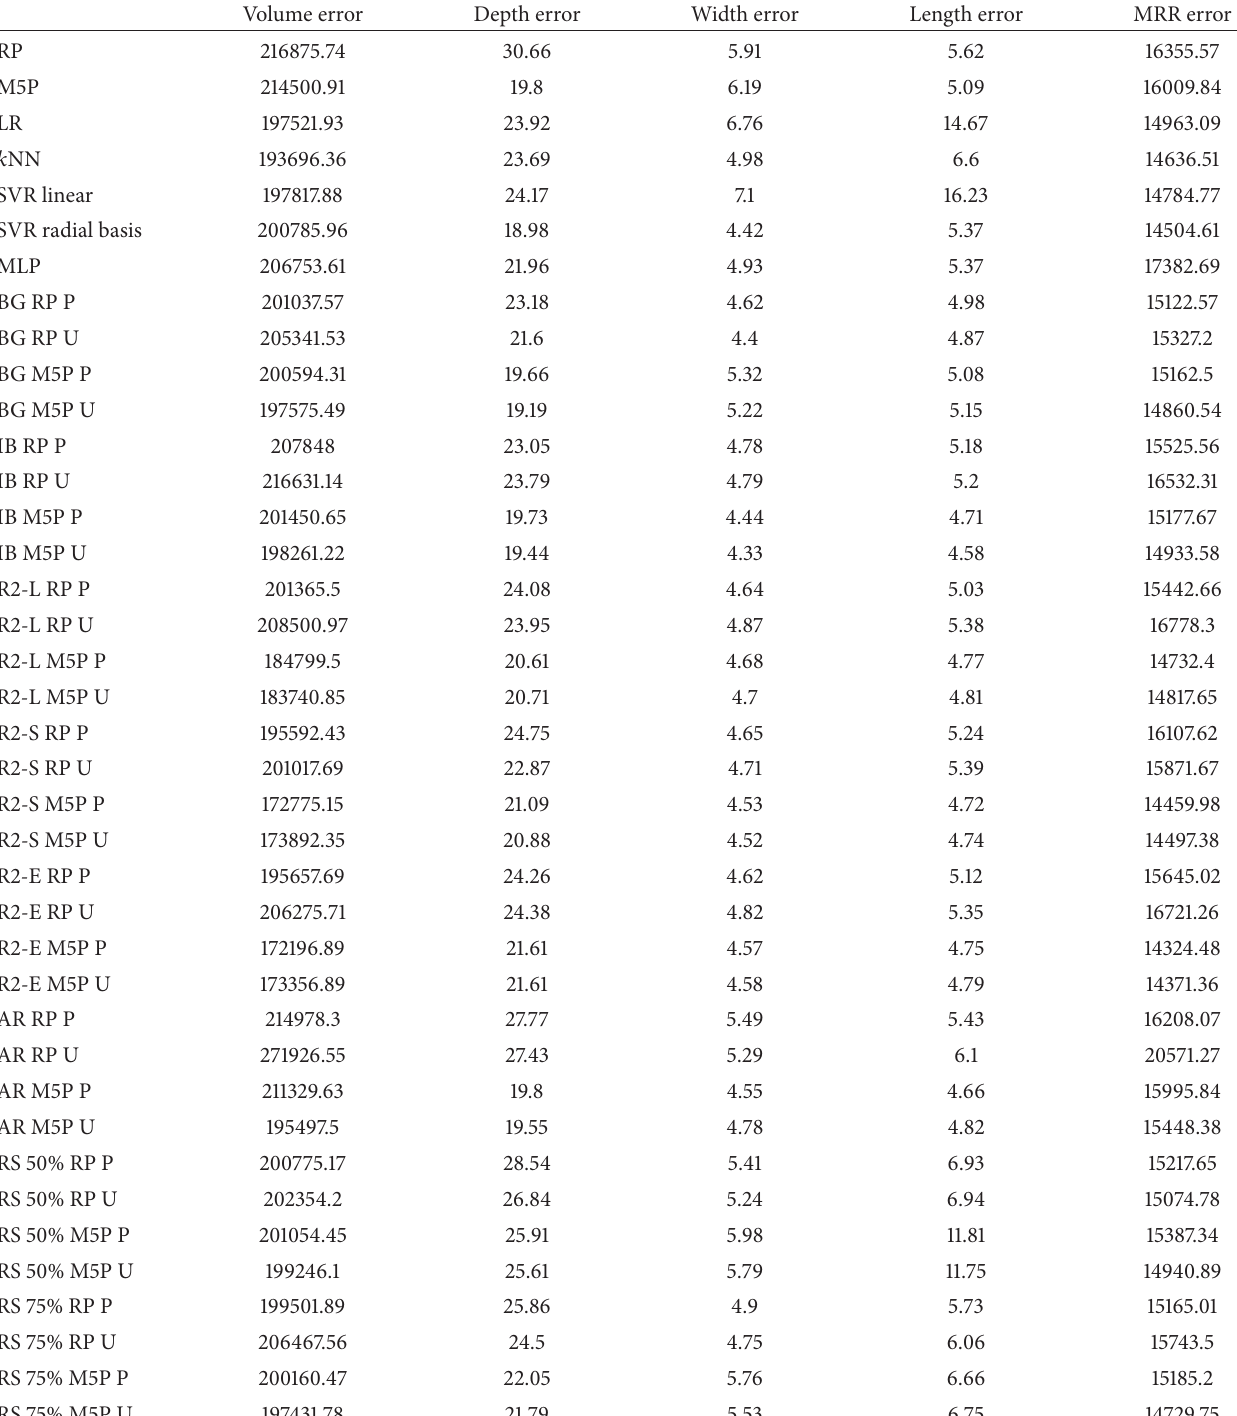
Table 8: Root mean squared error